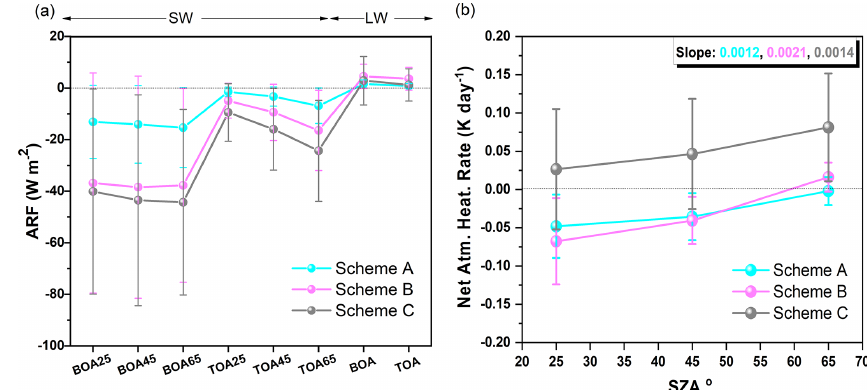
Figure 7. Mean values of (a) SW and LW ARF at BOA and TOA and (b) the net heating rate within the atmosphere, along with the SD for the three schemes applied in the total set of the studied cases. The box in the top right of (b) depicts the line slope.